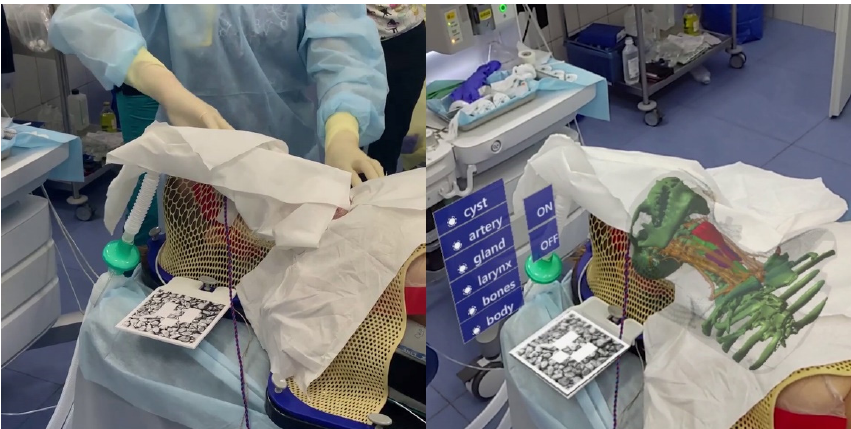
Figure 4. Referencing of the patient’s position in the operating room using a reference marker installed on a perforated thermoplastic cervicofacial mask-frame ( left ). Result: a 3D model of anatomical structures overlapping the patient as seen from the mixed reality glasses ( right ).